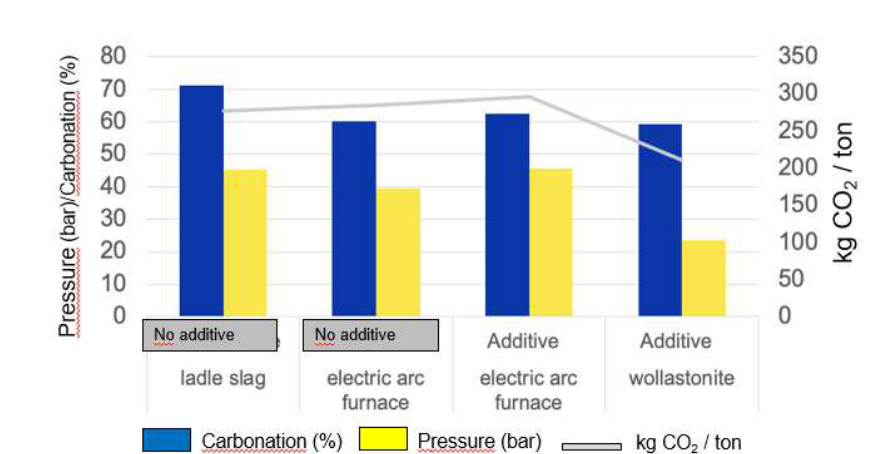
Figure 4 – Degrees of carbonation for different types of slag Рис. 4 – Степень карбонизации для